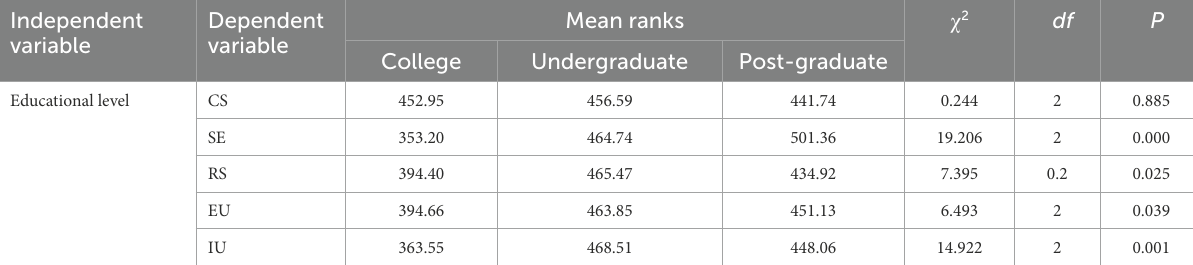
TABLE 4 Summary of Kruskal–Wallis test statistic.